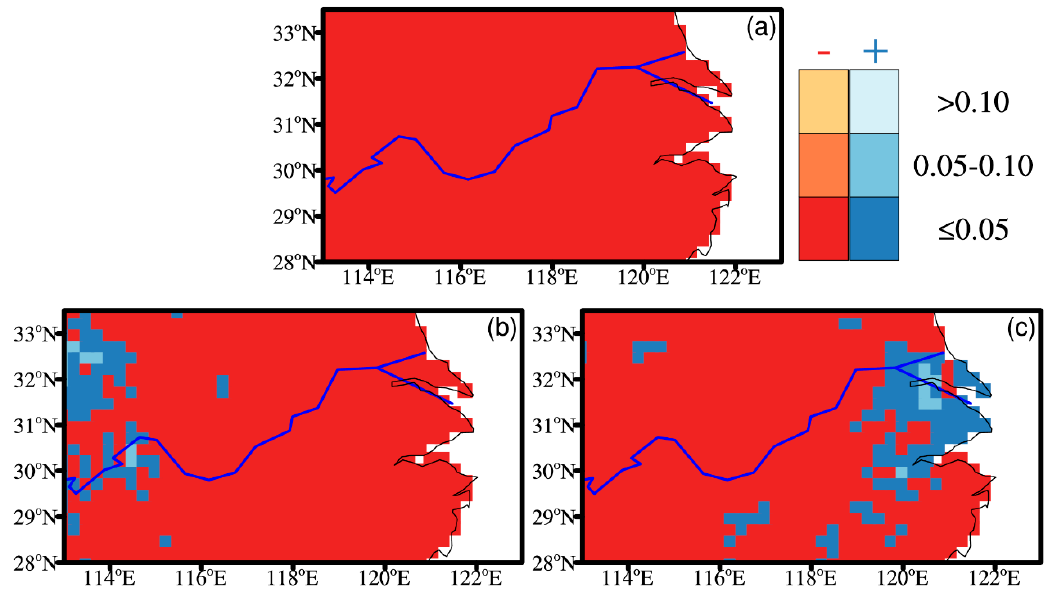
Figure 5. Relationship between summertime precipitation events associated with tropical cyclones (TCs) and El Niño–Southern Oscillation (ENSO) in spring, regression coefficients derived from Poisson regression display at different level of significance. ( a ) Normal rainfall events. ( b ) 75th percentile precipitation events. ( c ) 95th percentile precipitation events. The bold blue curve denotes the Yangtze River.